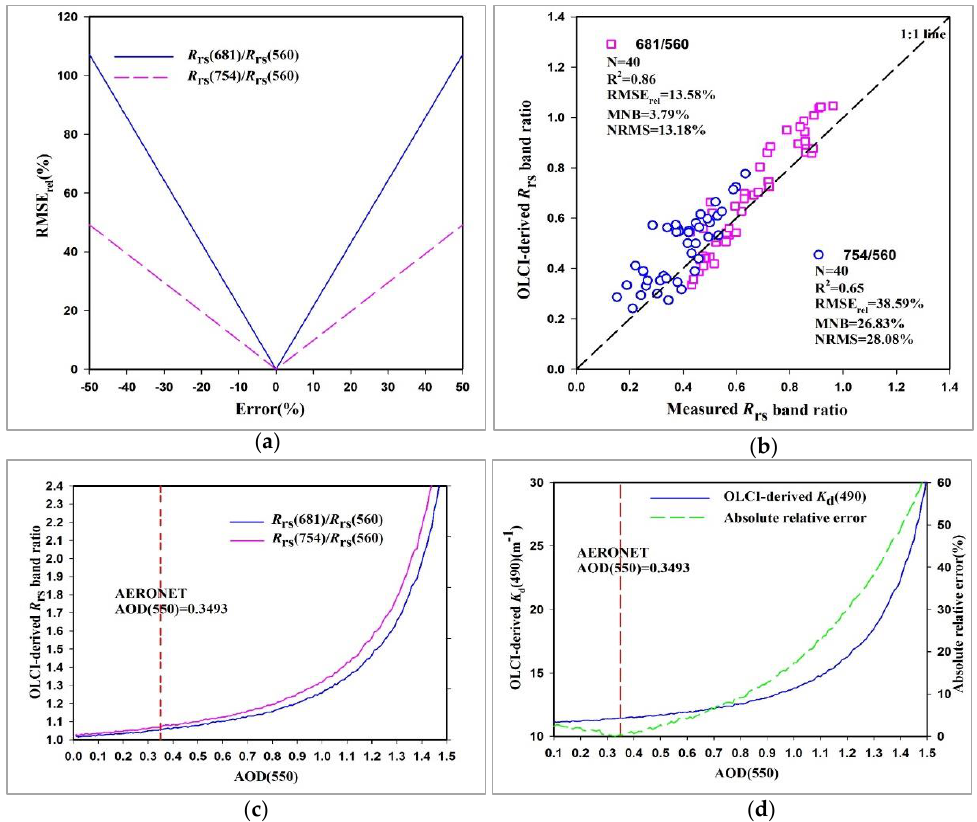
Figure 9. ( a ) Variation of RMSE rel for K d (490) derived from the errors introduced by R rs (681)/ R rs (560) and R rs (754)/ R rs (560) from the atmospheric correction; ( b ) comparison of the in situ measured R rs band ratios and the OLCI-derived R rs band ratios after the 6S atmospheric correction for R rs (681)/ R rs (560) and R rs (754)/ R rs (560); ( c , d ) examples showing the influence of the aerosol optical depth on the OLCI-derived R rs band ratios/ K d (490) at virtual station S1 on 14 March 2017.